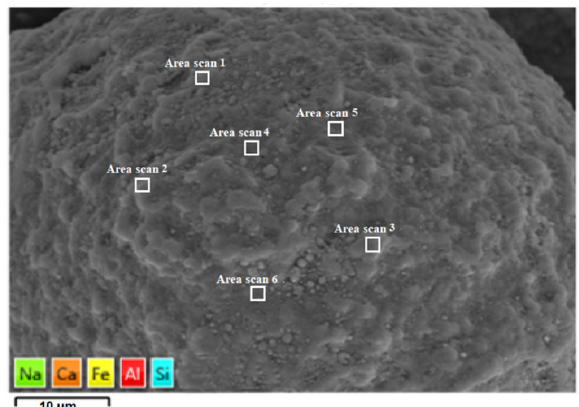
Figure 10. Area scan of a particle of CAT-CD. Table 3. SEM-EDS analysis results of the element contents on CAT-CD. Location